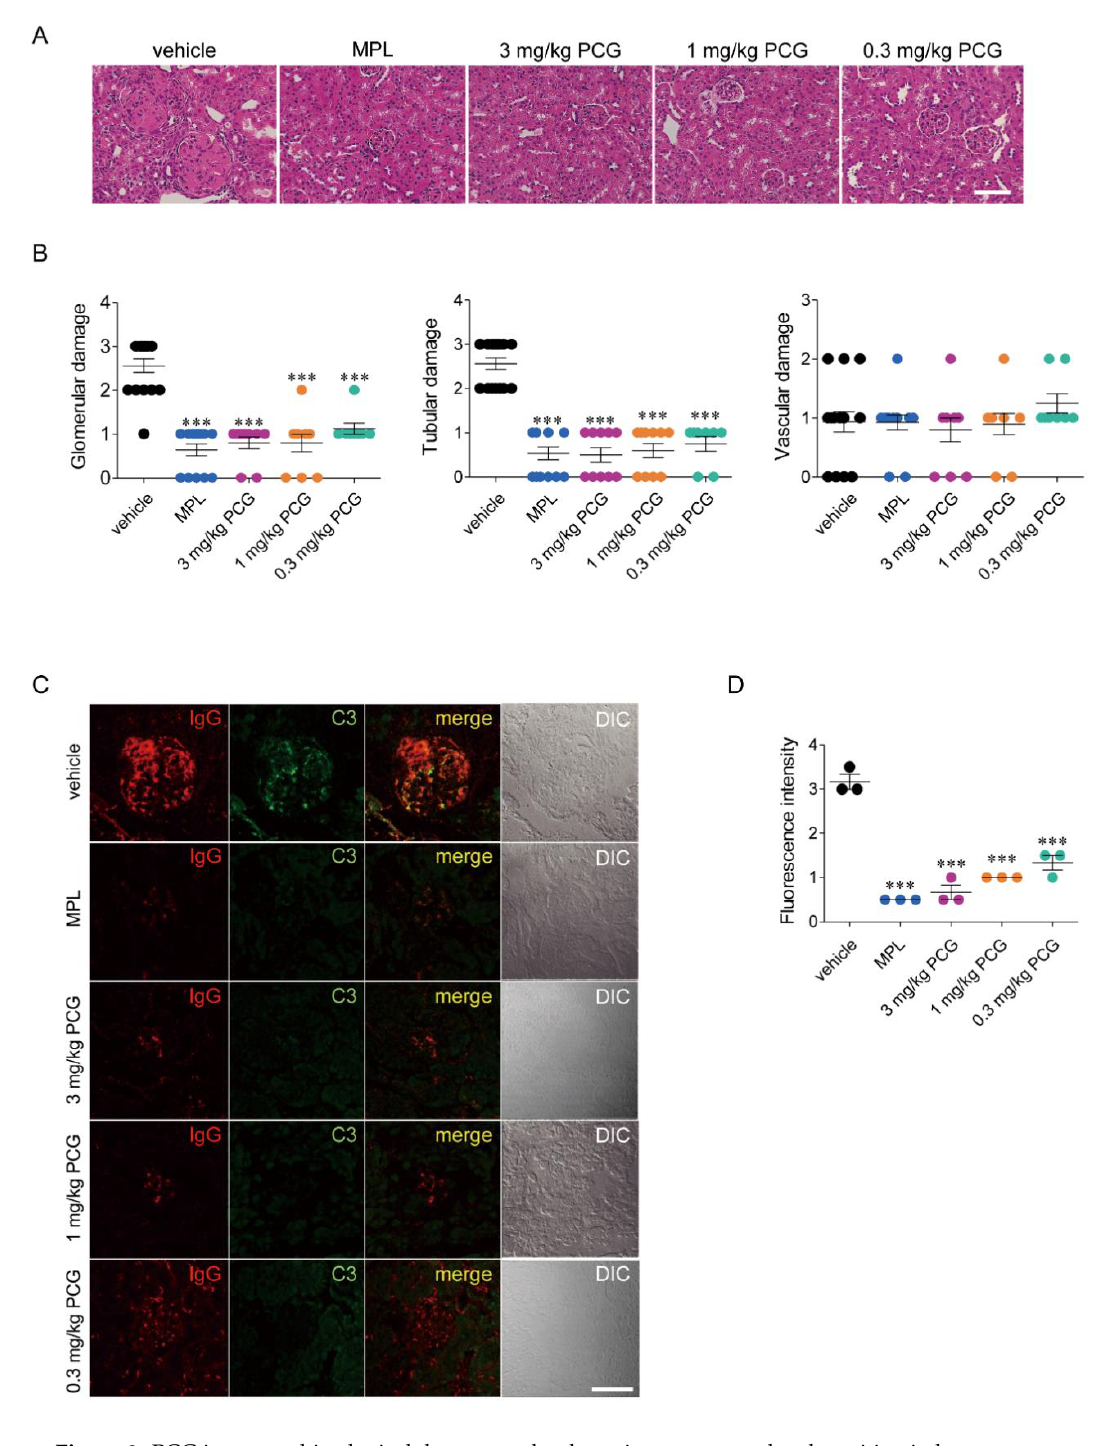
Figure 3. PCG improves histological damage and reduces immune-complex deposition in lupus-prone mice. ( A ) Periodic acid–Schi ff (PAS) staining of kidney tissues of NZB / W F1 mice at 30 weeks of age. Mice were treated with MPL and PCG 3 times a week. Bar = 50 µ m. ( B ) Summary of glomerular, tubular, and vascular damage in kidney tissues (mean ± SEM, n = 5–7 / group). ( C ) The deposition of immune-complex was evaluated by immunofluorescence staining of IgG (red) and complement 3 (green). Bar = 50 µ m. ( D ) The intensity of fluorescence was scored on a 4-point scale (mean ± SEM, n = 5–7 / group). *** p < 0.001 versus vehicle. Two-tailed Student’s t -test ( B and D ).